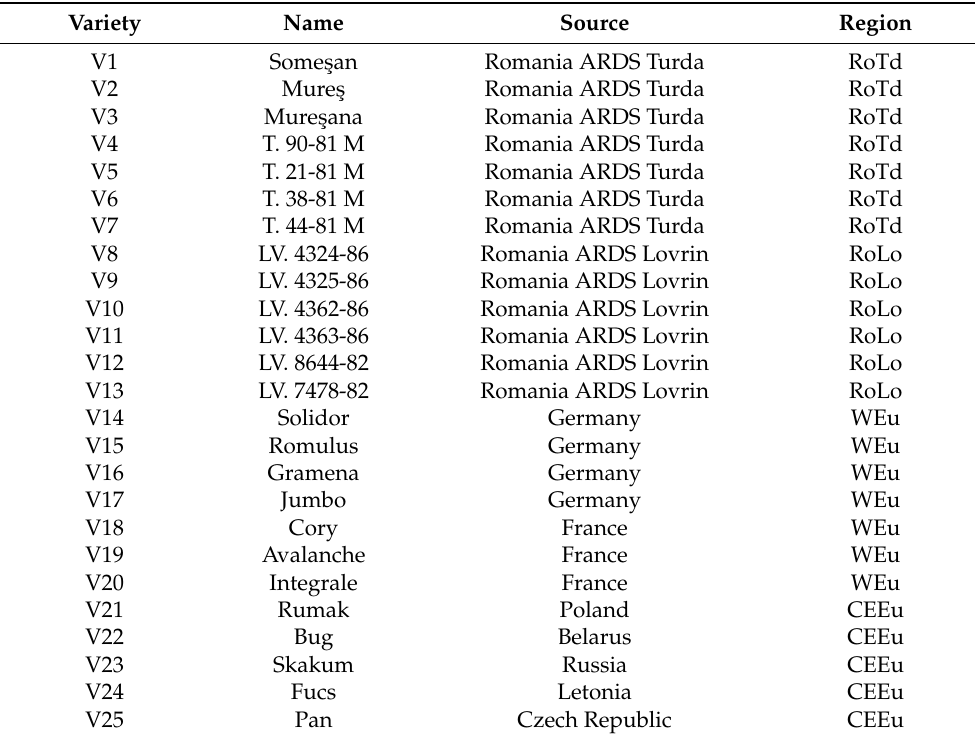
Table 1. The biological material used in the experiment.